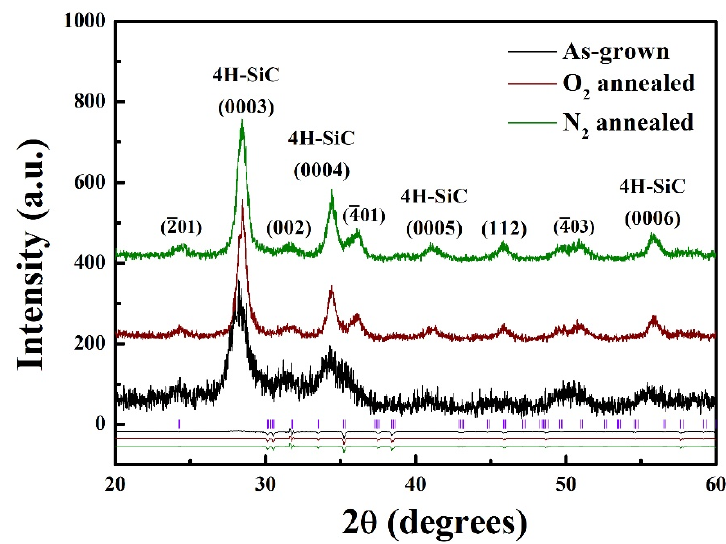
Figure 2. XRD spectra of samples and refinement results of Ga 2 O 3 annealed under different atmosphere.